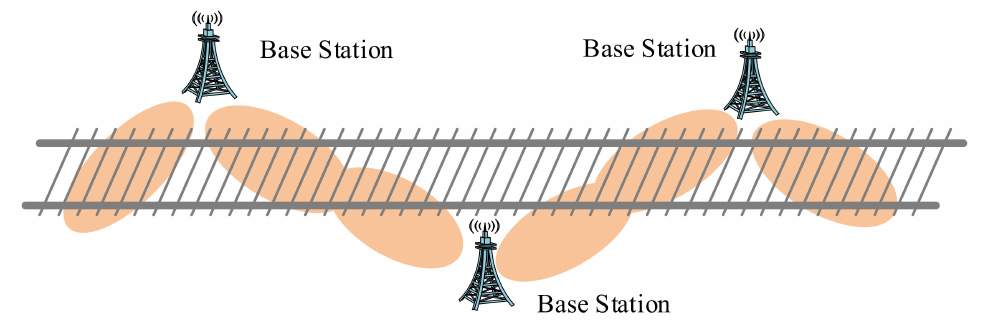
Figure 1. The layout of base stations built along the